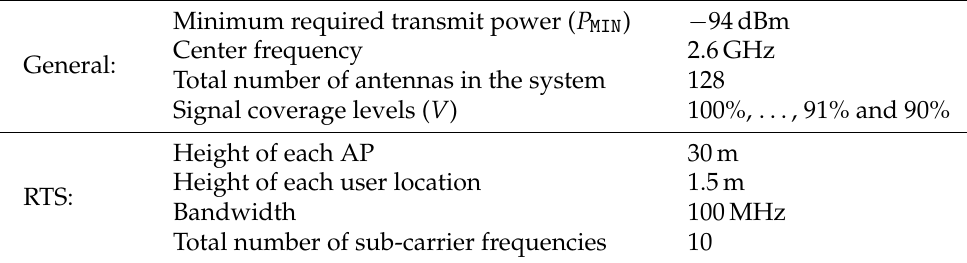
Table 2. Parameter settings.